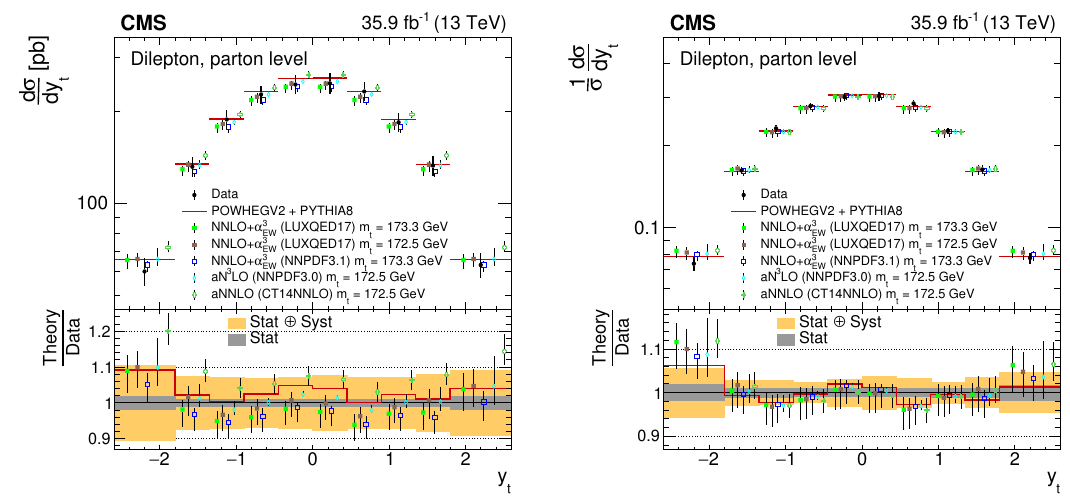
Figure 13 . The di(cid:11)erential tt production cross sections at the parton level in the full phase space as a function of y t are shown for the data ((cid:12)lled circles), the theoretical predictions with beyond- NLO precision (other points) and the prediction from powheg + pythia (solid line). The vertical lines on the (cid:12)lled circles and other points indicate the total uncertainty in the data and theoretical predictions, respectively. The left and right plots correspond to absolute and normalised measure- ments, respectively. The lower panel in each plot shows the ratios of the theoretical predictions to the data. The dark and light bands show the relative statistical and total uncertainties in the data, respectively.